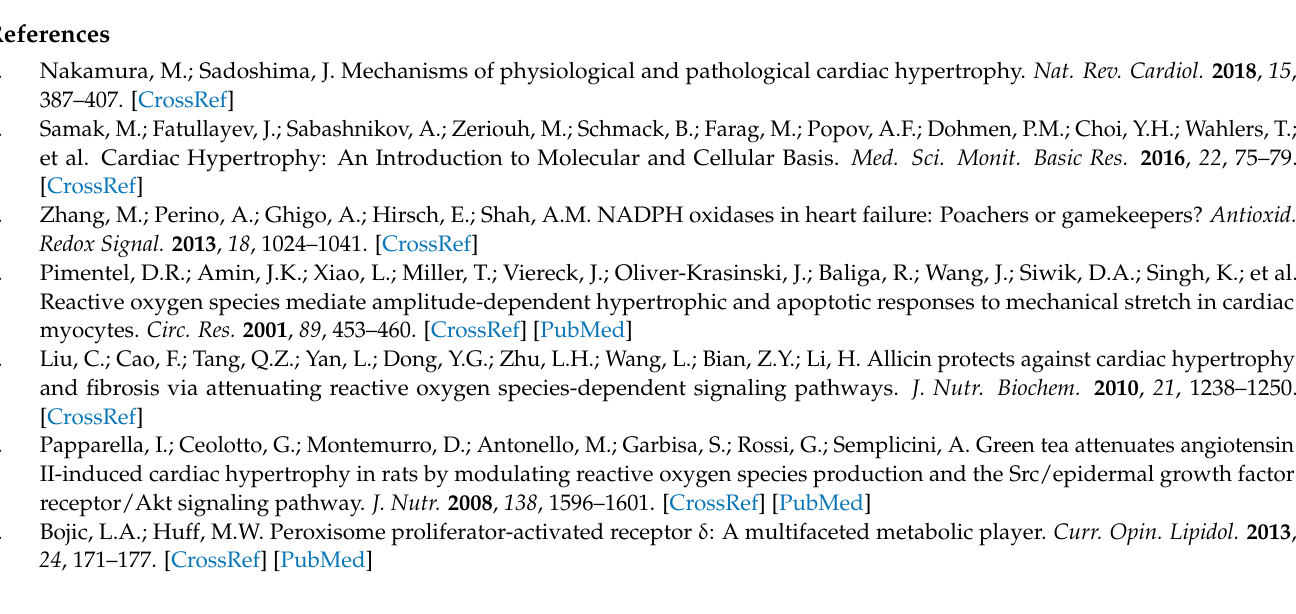
expression of catalase in H9c2 cardiomyocytes. Figure S4: Effects of siRNA targeting catalase or scrambled control sequences in H9c2